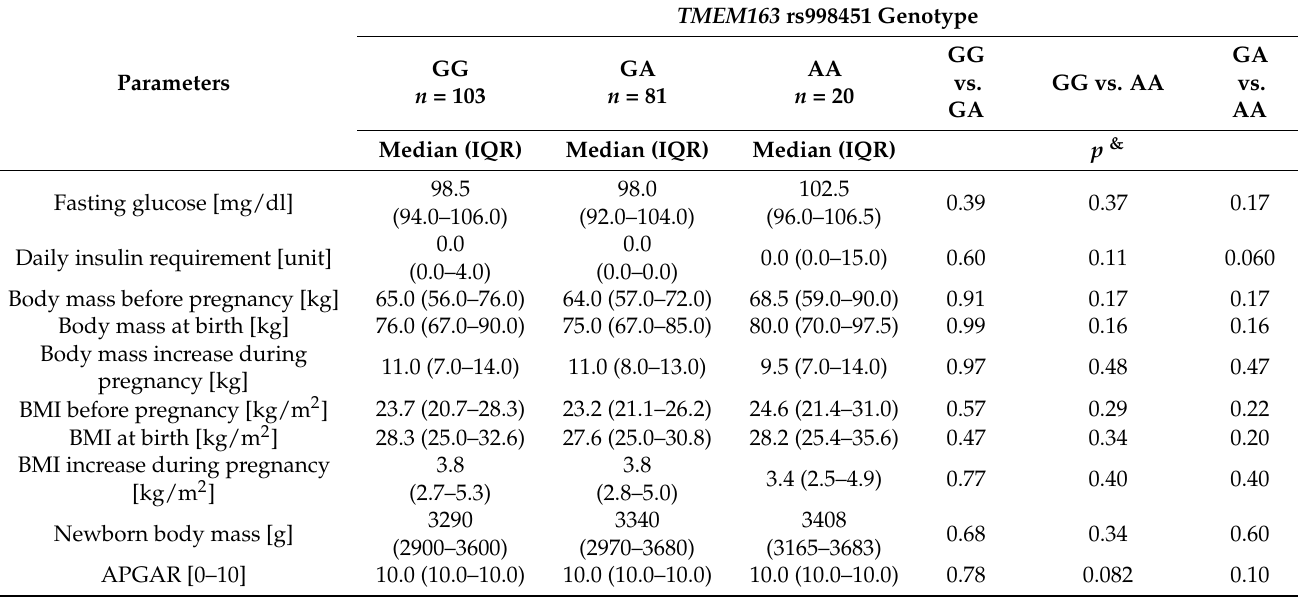
Table 4. Clinical parameters of women with GDM stratified according to TMEM163 rs998451 genotype.